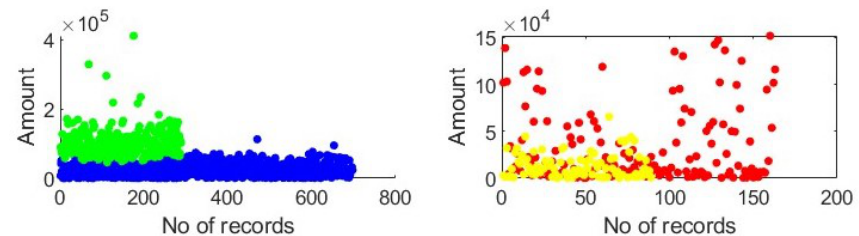
Figure 3. Clusters within